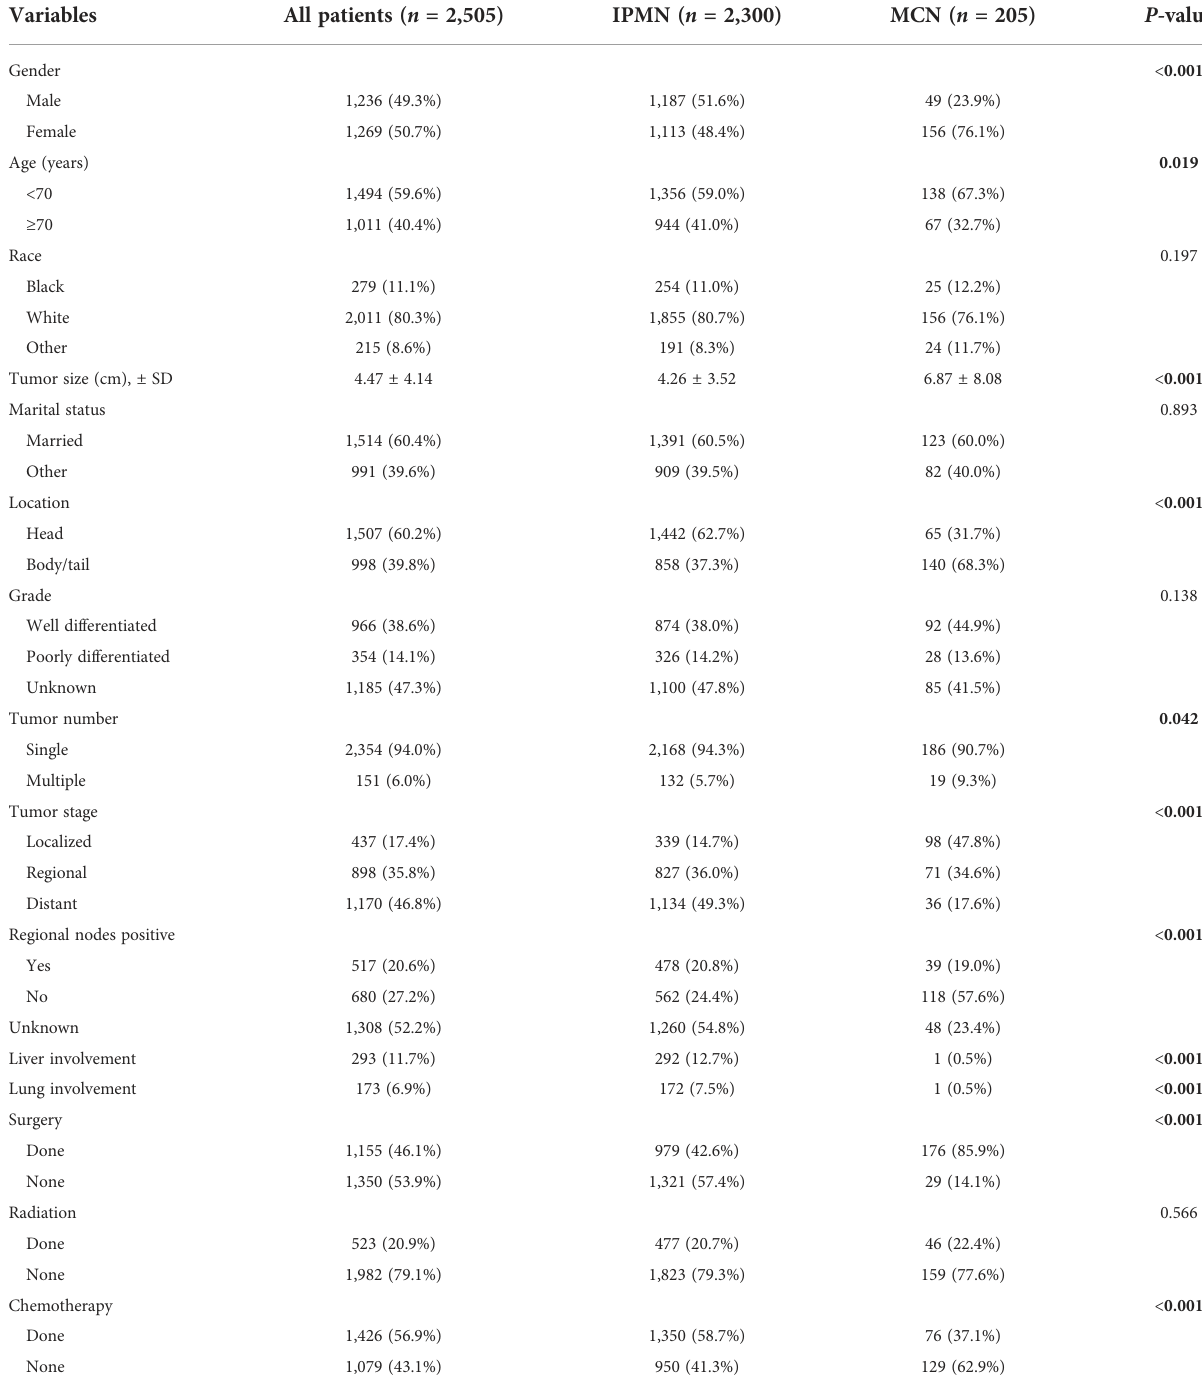
TABLE 1 Baseline characteristics of IPMN and MCN